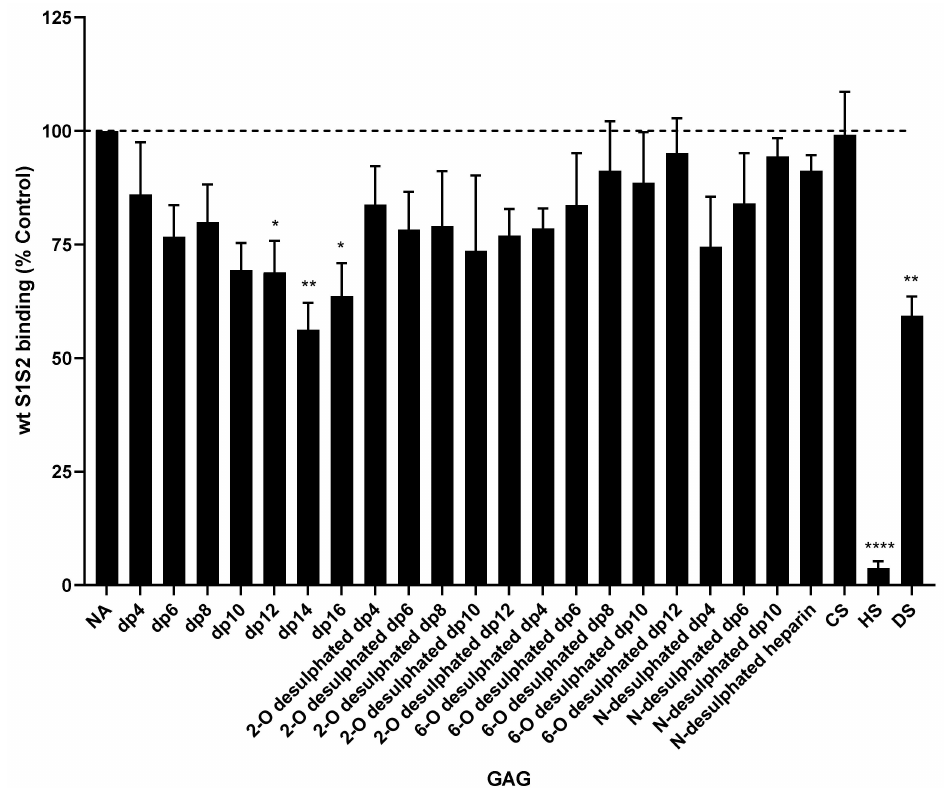
Figure 11. Inhibition of wtS1S2 binding to RT4 cells by heparins and glycosaminoglycans. RT4 cells were incubated with 100 µ g/mL of heparin or glycosaminoglycan for 30 min at 37 ◦ C, then with 33 nM wtS1S2 for a further 60 min at 37 ◦ C and bound protein detected using fluorescent secondary anti-His6. Cell-associated fluorescence was measured by flow cytometry and data are shown as a percentage of wtS1S2 attachment to untreated control cells. Data are the means ± SEM of 4–6 separate experiments performed in duplicate. Significance of difference from the control was assessed by a one-sample t test: not significant unless otherwise stated; * p < 0.05; ** p < 0.001; **** p < 0.00001.